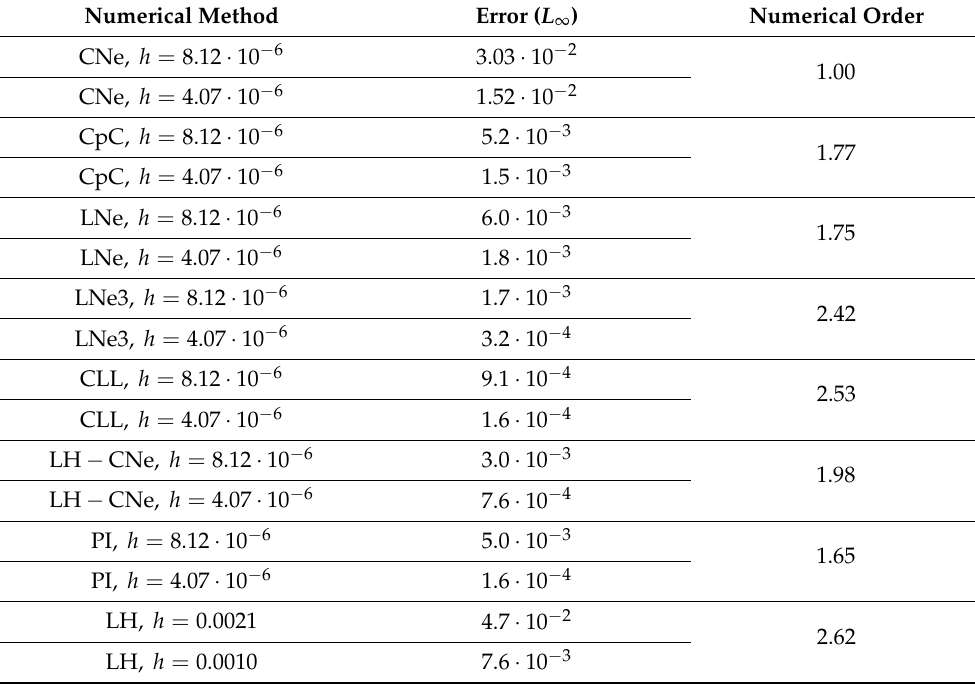
Table 1. Errors and numerical order of different algorithms for Experiment 1. Numerical